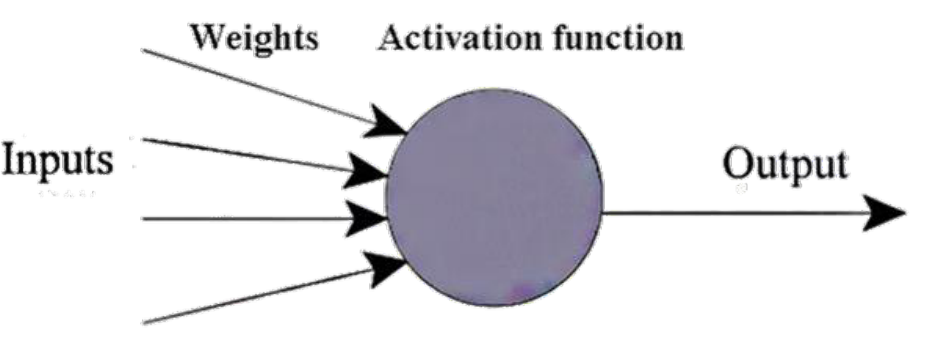
Figure 1. An artificial neuron.